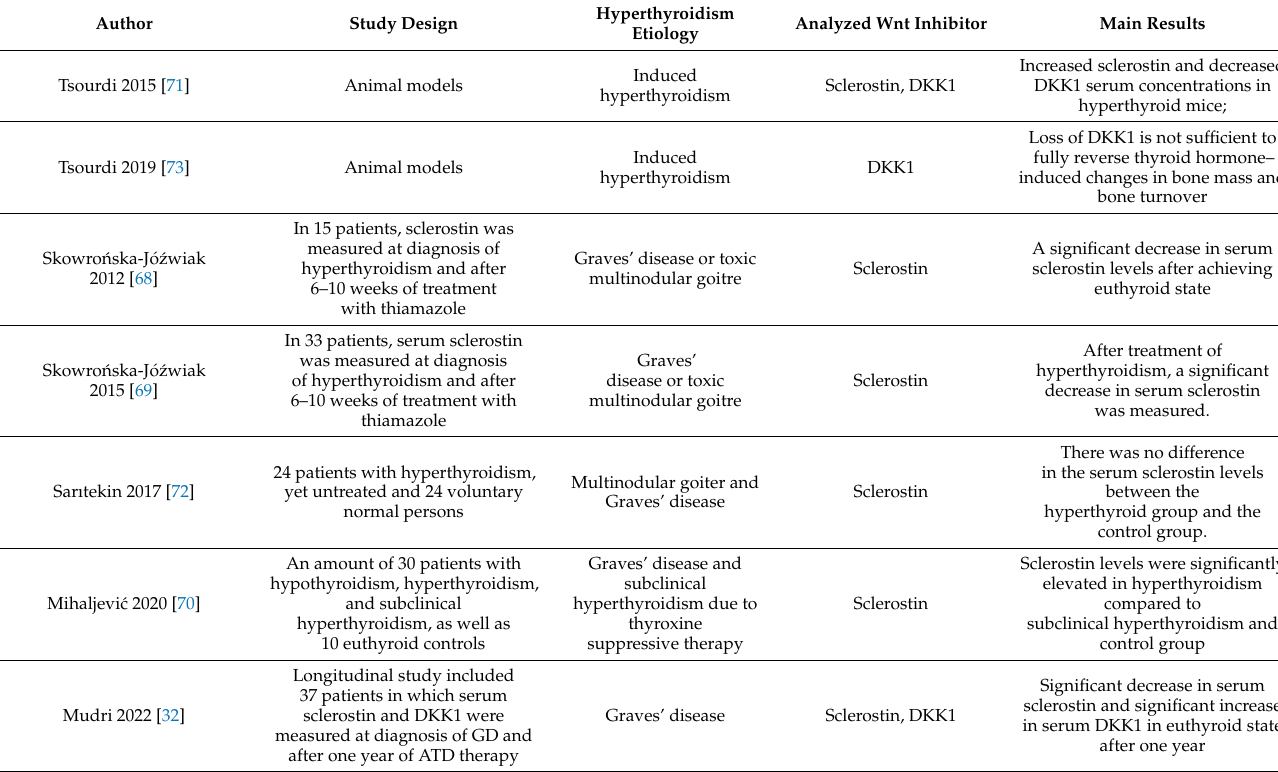
Table 1. List of studies investigating hyperthyroidism and Wnt inhibitors, and this includes main